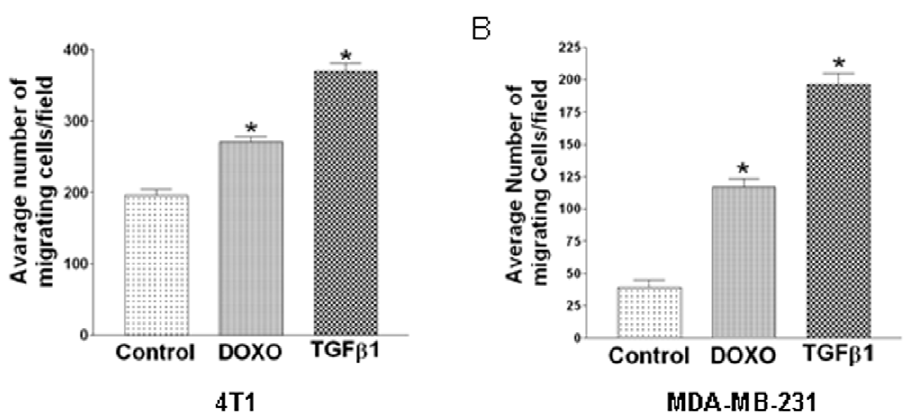
Figure 1. Stimulation of migration by doxorubicin and TGF b treatment in murine and human breast cancer cells. In a Boyden Chamber migration assay, 40,000 murine breast cancer 4T1 cells ( A ) and human breast cancer MDA-MB-231 cells ( B ) in serum free medium were placed inside the insert of an invasive chamber and treated with doxorubicin (100 nM) or TGF b 1 (5 ng/ml in A and 1 ng/ml in B ) for 6 hours (4T1 cells) and 24 hours (MDA-MB-231 cells). Lower chamber contained the medium with 1% serum as chemoattractant. Cells were removed from the upper surface of the chamber membrane and the membrane was then stained for the migratory cells, which were counted under a microscope. Results are the mean of the five fields of observation at 100 6 magnification and expressed as mean + SEM. ‘‘*’’ indicates significant difference from the control value with ANOVA test, P , 0.05.